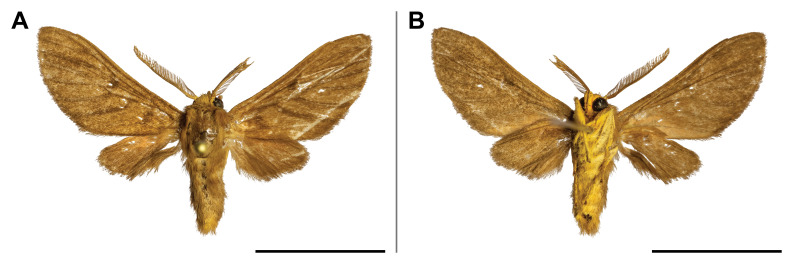
Anapisa
holobrunnea Tams, 1932. A. dorsal view; B. ventral view. The scale bar represents 1 cm.